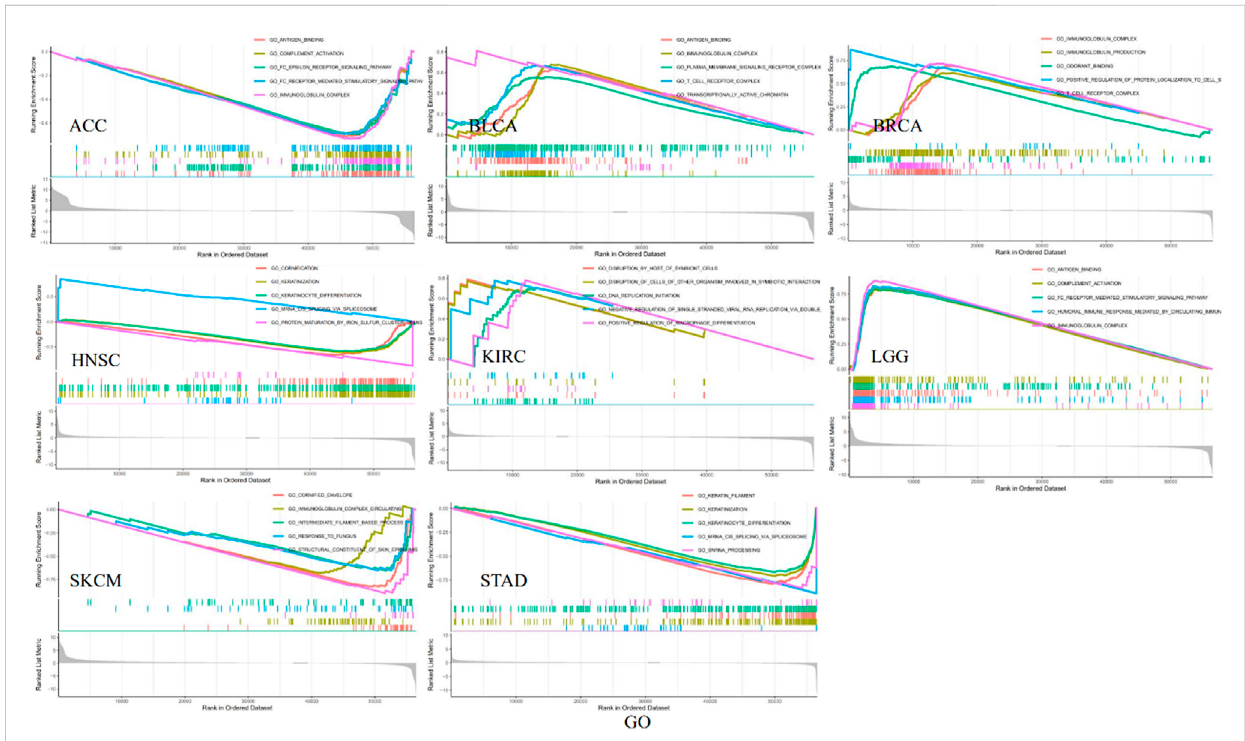
FIGURE 10 GO functional terms of IKBIP in various each cancer type in the high-risk group and low-risk